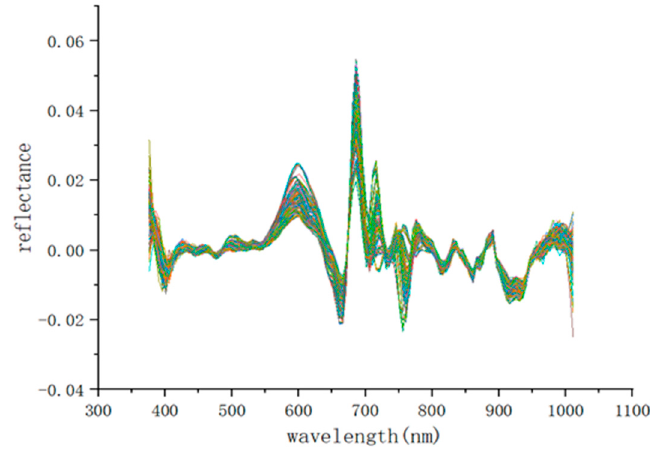
Figure 4. Savitzky–Golay + first-order difference preprocessing diagram.